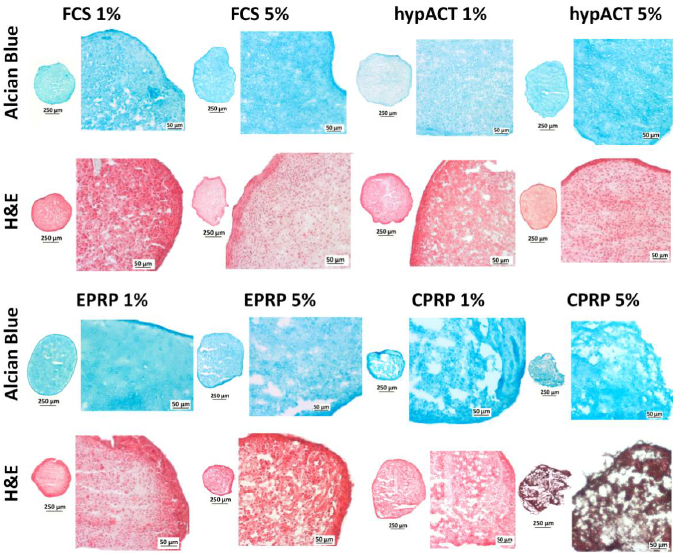
Figure 3. Histology results (CPRP = citrate platelet-rich plasma, EPRP = EDTA platelet-rich plasma, FCS = fetal calf serum, H&E = hematoxylin and eosin, hypACT = hyperacute serum). Histological slices derived from pellets supplemented with FCS 5%, hypACT 5% and EPRP 1% show a confined ECM morphology and good tissue quality. Samples from FCS 1%, hypACT 1% and EPRP 5% show a diffuse but homogenous ECM morphology and average tissue quality, however, based on this qualitative assessment the pellets from EPPR 5% group, seem to have slightly more fissures than FCS 1% and hypACT 1%. Cuts from 1% and 5% CPRP groups show a diffuse and heterogenous ECM composition with poor